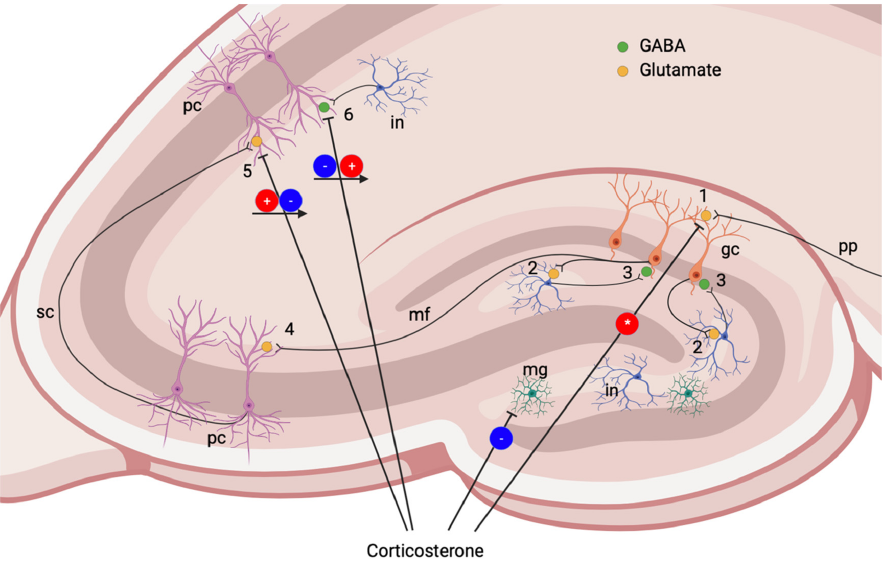
Figure 3. Corticosterone effects in the hippocampus at rest and during acute stress. 1, Glutamatergic synapse on granular cell. In normal conditions, granular cells are almost insensitive to physiological GSs changes, including acute stress, but extremely low levels of GCs reduce neuronal activity of granular cells [88]. 2, Glutamatergic collateral to an interneuron. 3, GABAergic synapse on granular neuron. Though little data on the modulation by GCs of collateral inhibition in the DG are available, the effects of GCs on pyramidal cells of CA1 field may be similar. 4, Glutamatergic synapse on pyramidal neuron of CA3 field. 5, Glutamatergic synapse on pyramidal neuron of CA1 field. Pyramidal neurons demonstrate U-shaped modulation by GCs: very low (not physiological), as well as very high CS levels suppress neuronal activity, but intermediate doses increase EPSP amplitude [83,85,86]. 6, GABAergic synapse on pyramidal neuron. GCs may temporarily reduce IPSP with subsequent rapid or slow elevation of inhibitory postsynaptic potential (IPSP) amplitude [93,94]. pp, perforant path; gc, granular cell; mf, mossy fibers; pc, pyramidal cells (CA3 and CA1 fields), sc, Schaffer collateral; in, interneuron. Red circle (+)—activating action; red circle (*)—activation by very low GC levels; blue circle ( − )—inhibiting action; arrows show changes in GC action with increasing concentration or over